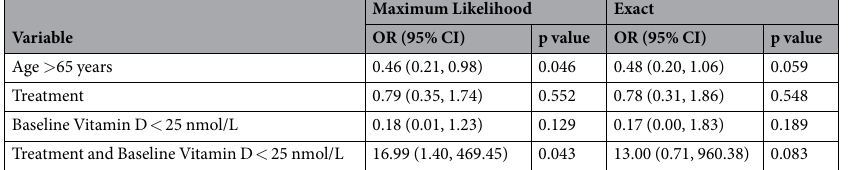
Table 3. Effect of vitamin D adjunctive therapy and baseline vitamin D deficiency ( < 25 nmol/L) on complete resolution of CAP and being alive at 6 weeks post-treatment. Odds Ratio (OR) with 95% Confidence Intervals (CI) and p values from logistic regression fitted with Maximum Likelihood or Exact